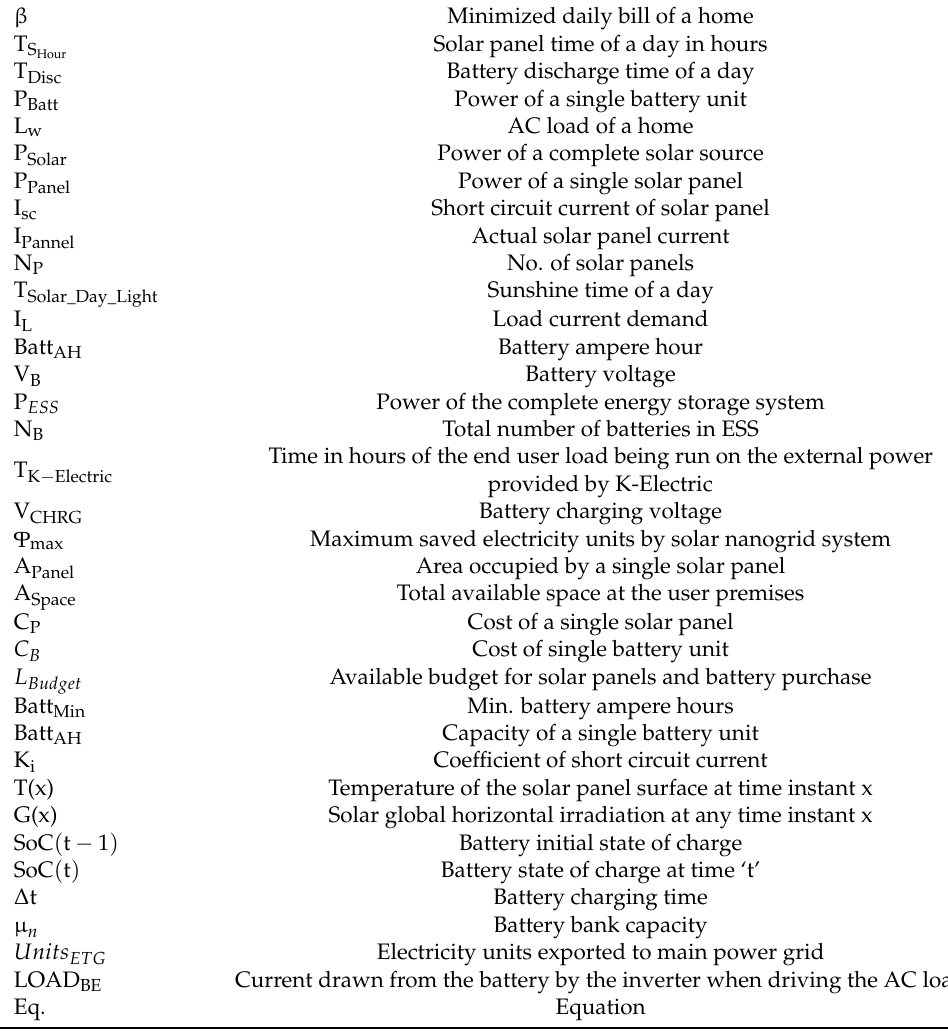
Table 1. Important notations and descriptions.